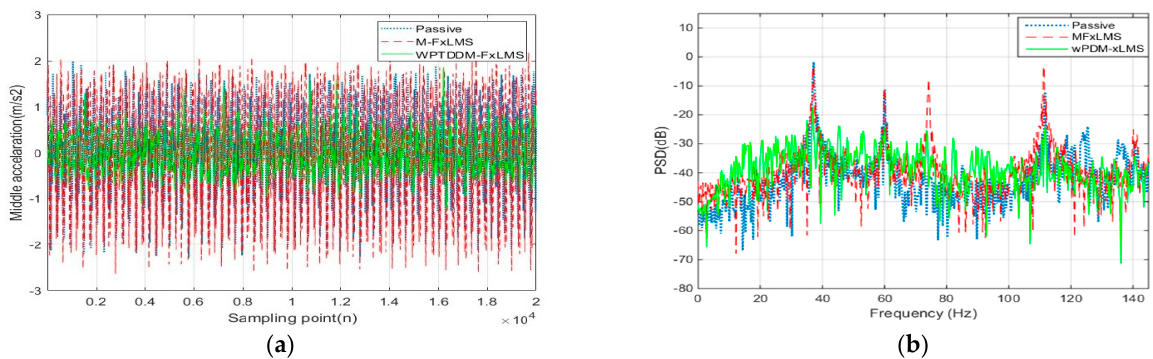
Figure 16. ( a ) The time domain acceleration signal in measuring point 1#; ( b ) the acceleration signal spectrum in measuring point 1#.